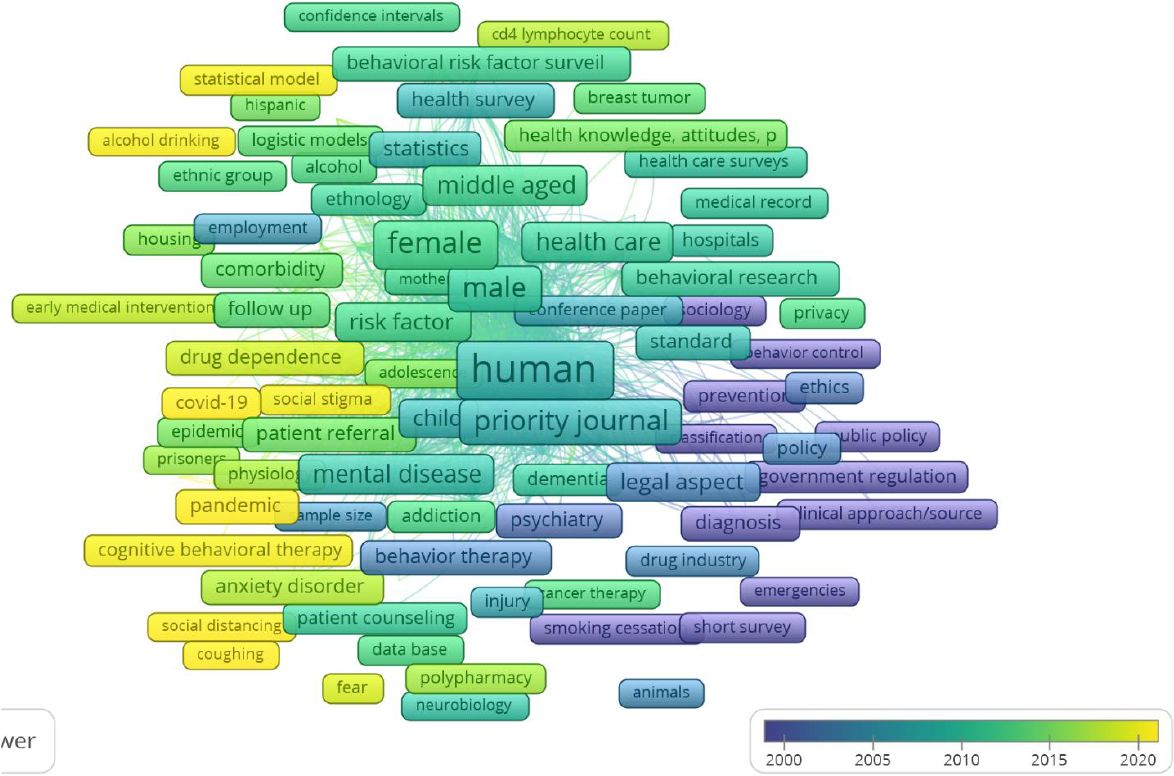
Figure 2. Visualization map of contextual and temporal measurement of scientific research in papers from the Scopus database of categories “health care system, medical services, behavioral aspect, social aspect” in dynamics for 2000-2020 using the VOSViewerv software toolkit. 1.6.15 Sources: developed/compiled/systematized by the authors based on the Scopus database using the VOSViewerv software toolkit.1.6.15 (Dotsenko, 2022).